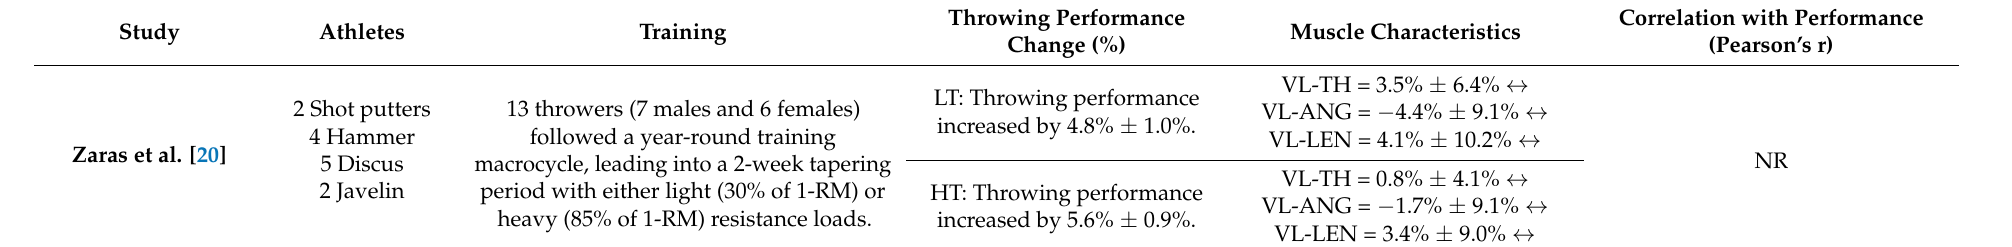
Table 4. Changes in muscle architecture characteristics following long-term periodized training and correlations between muscle architecture characteristics and track and field throwing performance in track and field